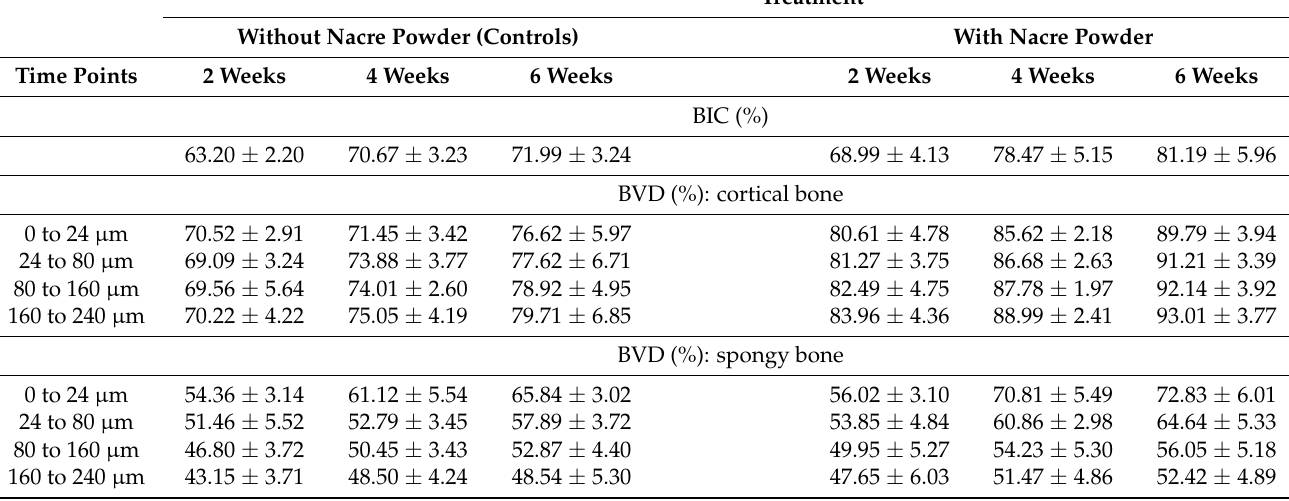
Table 1. BIC and BVD percentages of implantation without and with nacre powder at different time points.